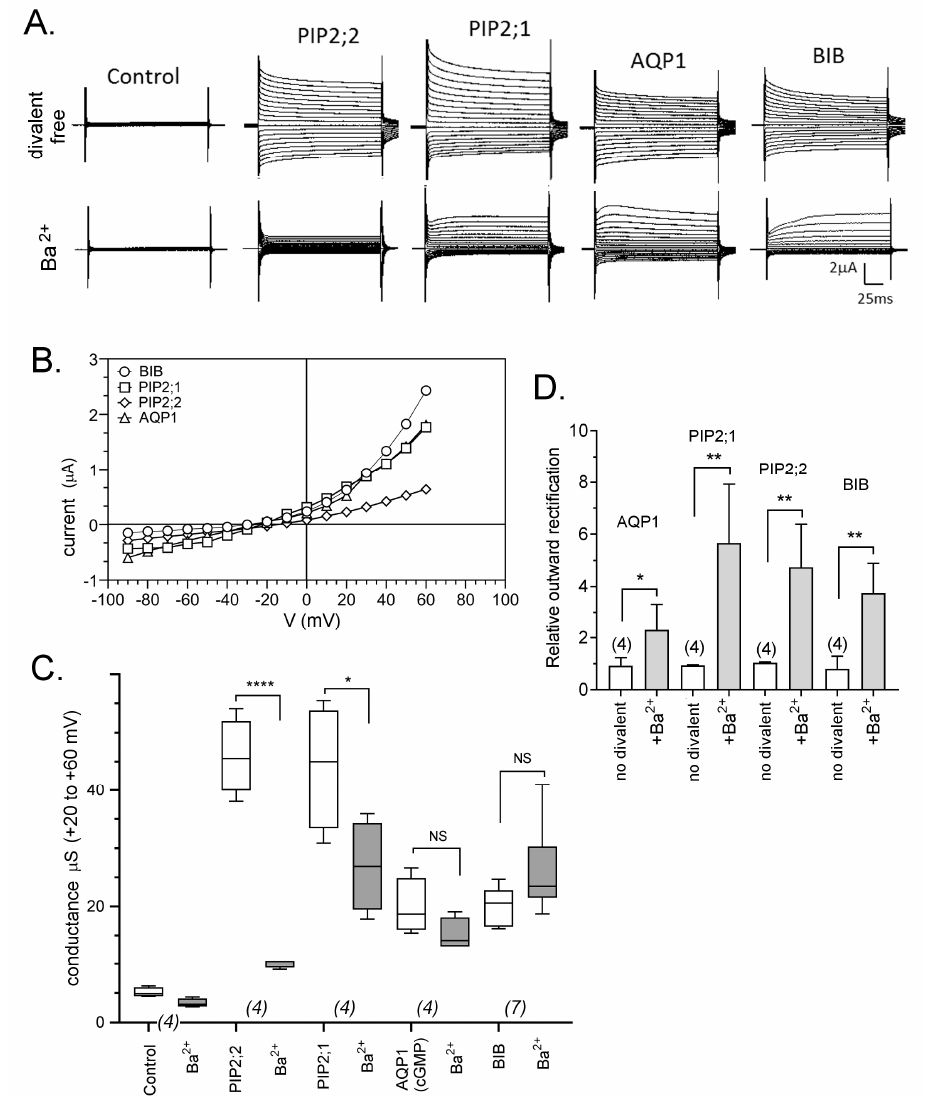
Figure 3. Effects of Ba 2+ on ionic currents in oocytes expressing different AQPs. ( A ) Superimposed current traces as a function of time measured by voltage clamp at maximal activation in divalent-free saline ( upper row) and after perfusion with bath saline containing 1 mM BaCl 2 ( lower ). ( B ) Current-voltage relationships in Ba 2+ for traces presented in ( A ). ( C ) Box plot summary of compiled data for AQP1, PIP2;1, PIP2;2 and BIB channels before and after 1 mM Ba 2+ application. ( D ) Histogram showing the relative outward rectification values (I +60 /I − 80 ) as mean ± SEM. Ratios were calculated as amplitude of outward (+60 mV) to inward ( − 80 mV) currents. **** ( p < 0.0001); ** ( p < 0.001); * ( p < 0.01); NS (not significant); using ANOVA with post-hoc Bonferroni tests. n values are near the x -axis.